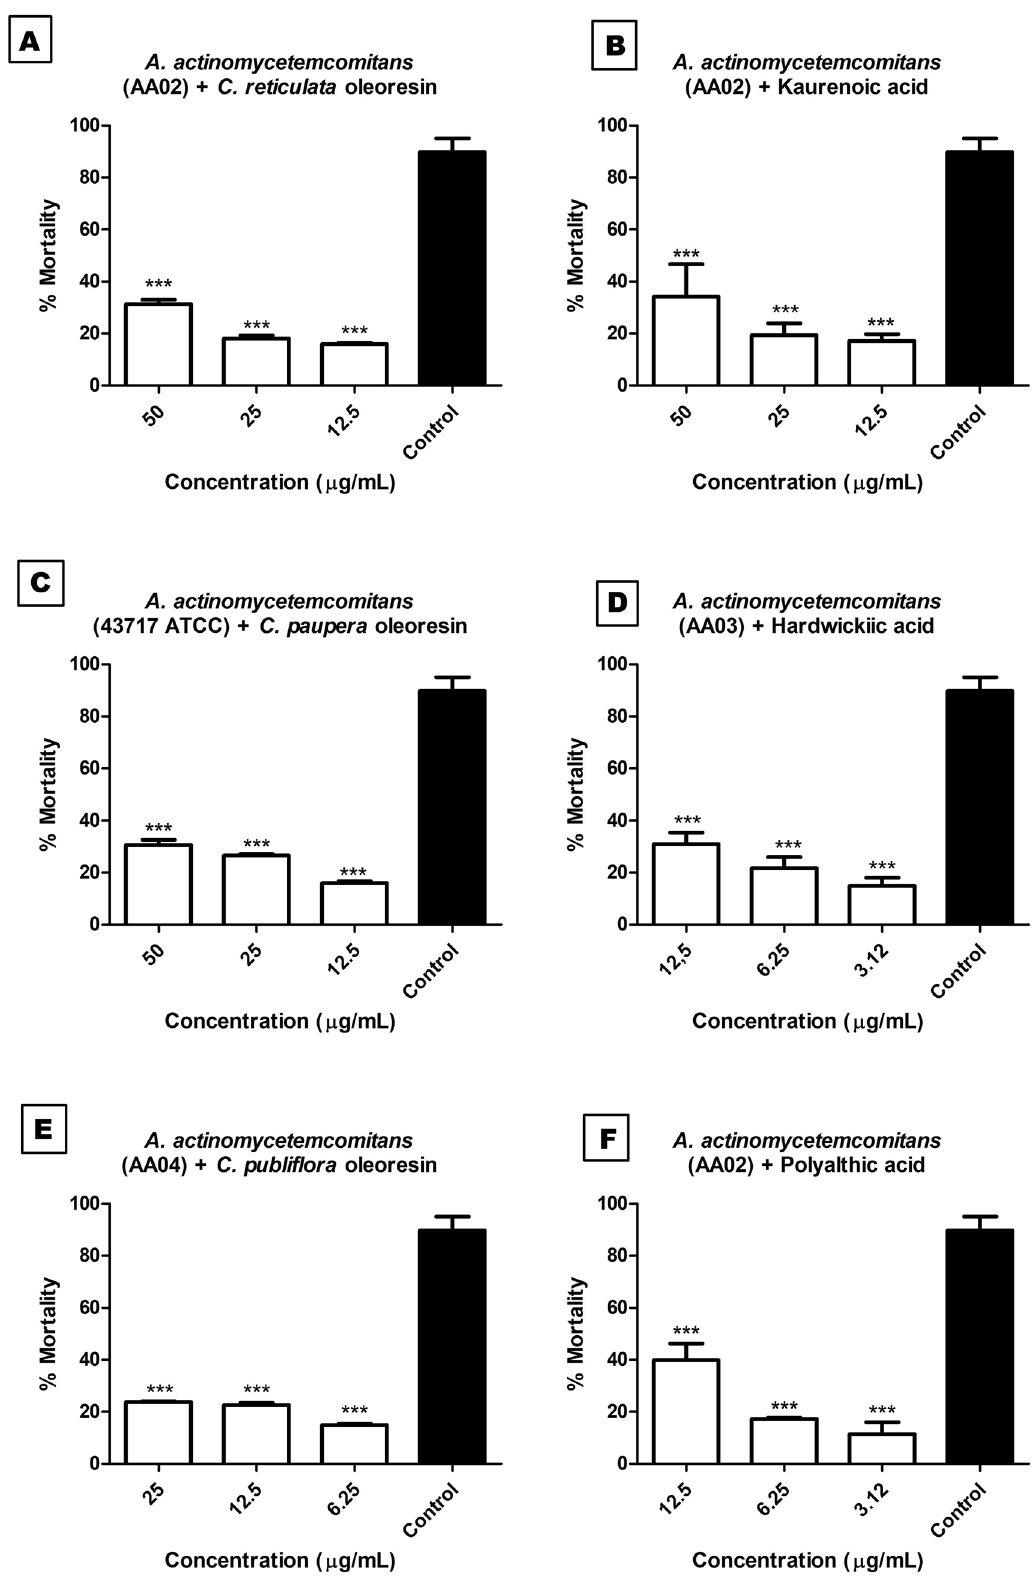
Figure 6. Mortality percentage of human mononuclear cells after exposure to the oleoresins ( A , C , E ) and the isolated compounds kaurenoic acid ( B ), polyalthic acid ( F ), and hardwickiic acid ( D ) and the control (Triton-X). Values are expressed as mean and standard deviation in triplicate. Triple asterisks ( P < 0.001) indicate significantly different values versus control values. Data were analyzed using GraphPad Prism software version 5.00 (available https ://www.graph pad.com/scien tific -softw are/prism